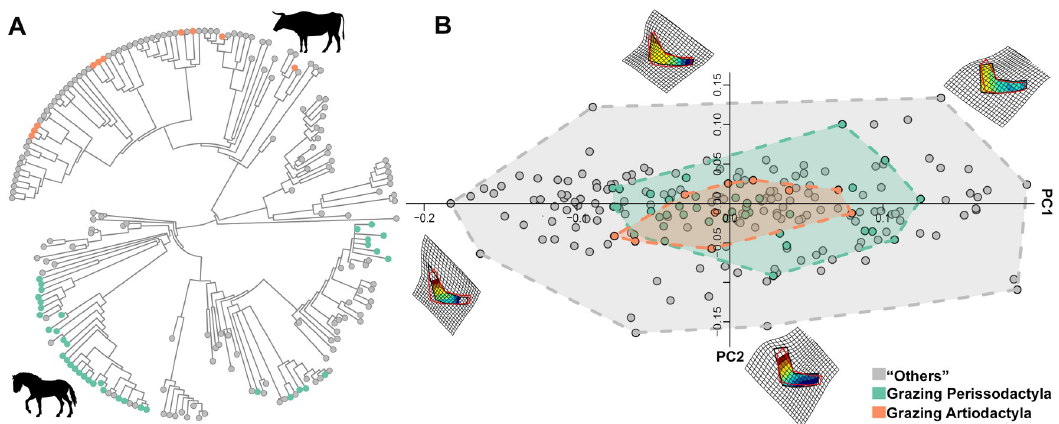
Fig 6. Convergence among mandibular shapes in ungulates. A) The distribution of individual species per state (gray = background state (others), orange = grazing artiodactyls, green = grazing perissodactyls) on the ‘ungulate’ tree. B) PC1/PC2 plot showing the position of the convergent states (grazers) compared to the rest of the tree. Deformation grids are shown at the extremes of both axes. Animal silhouettes were available under Public Domain license at phylopic (http://phylopic.org/). Specifically, Bos primigenius (http://phylopic.org/image/dc5c561e-e030-444d-ba22-3d427b60e58a/) image by DFoidl (modified by T. Michael Keesey) and Equus ferus (http://phylopic.org/image/85d95128-912c-427a-9542-138e1dbf5651/) image by Mercedes Yrayzoz (vectorized by T. Michael Keesey) are available for reuse under the Creative Commons Attribution 3.0 Unported (https://creativecommons.org/licenses/by-sa/ 3.0/).